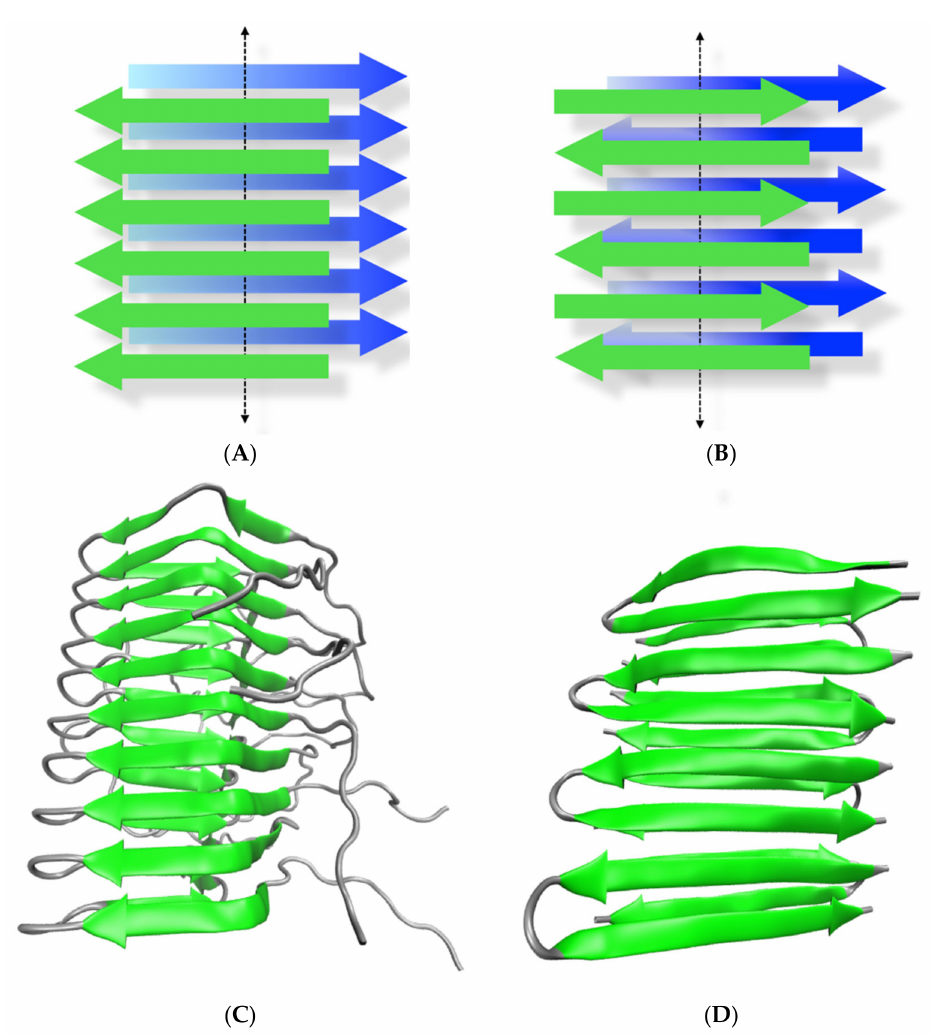
Figure 1. The amyloid conformation. ( A , B ) represent the most common beta-sheet tridimensional arrangements of amyloids in parallel and anti-parallel conformation, respectively. In each state, two intermolecular beta-sheets (depicted in green and blue) run in a cross fashion (cross beta) through the perpendicular axis of the growing fibril (dotted arrow). ( C ) Ribbon representation of the tridimensional structure of the HET protein in its amyloid conformation solved by solid-state NMR in a parallel arrangement (PDB code 2RNM). ( D ) Ribbon representation of the tridimensional structure of a de novo designed peptide in an antiparallel amyloid conformation solved by solid-state NMR (PDB code